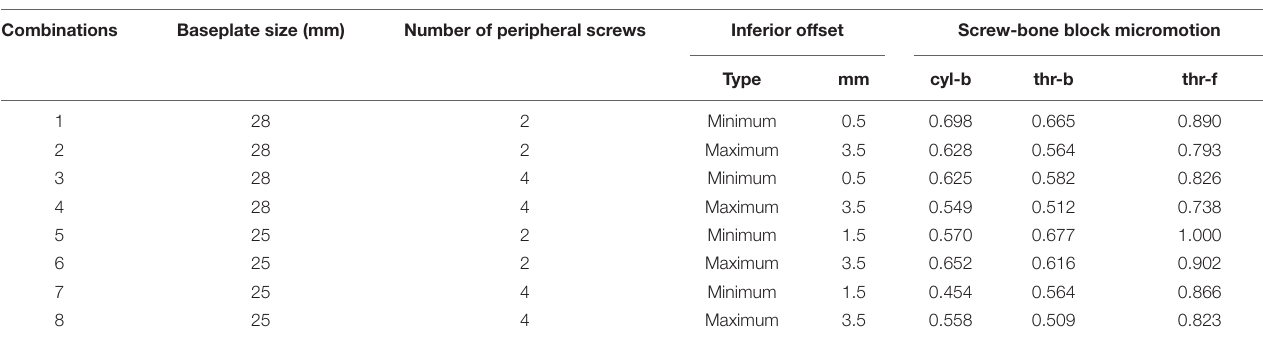
TABLE 2 | Normalized micromotion